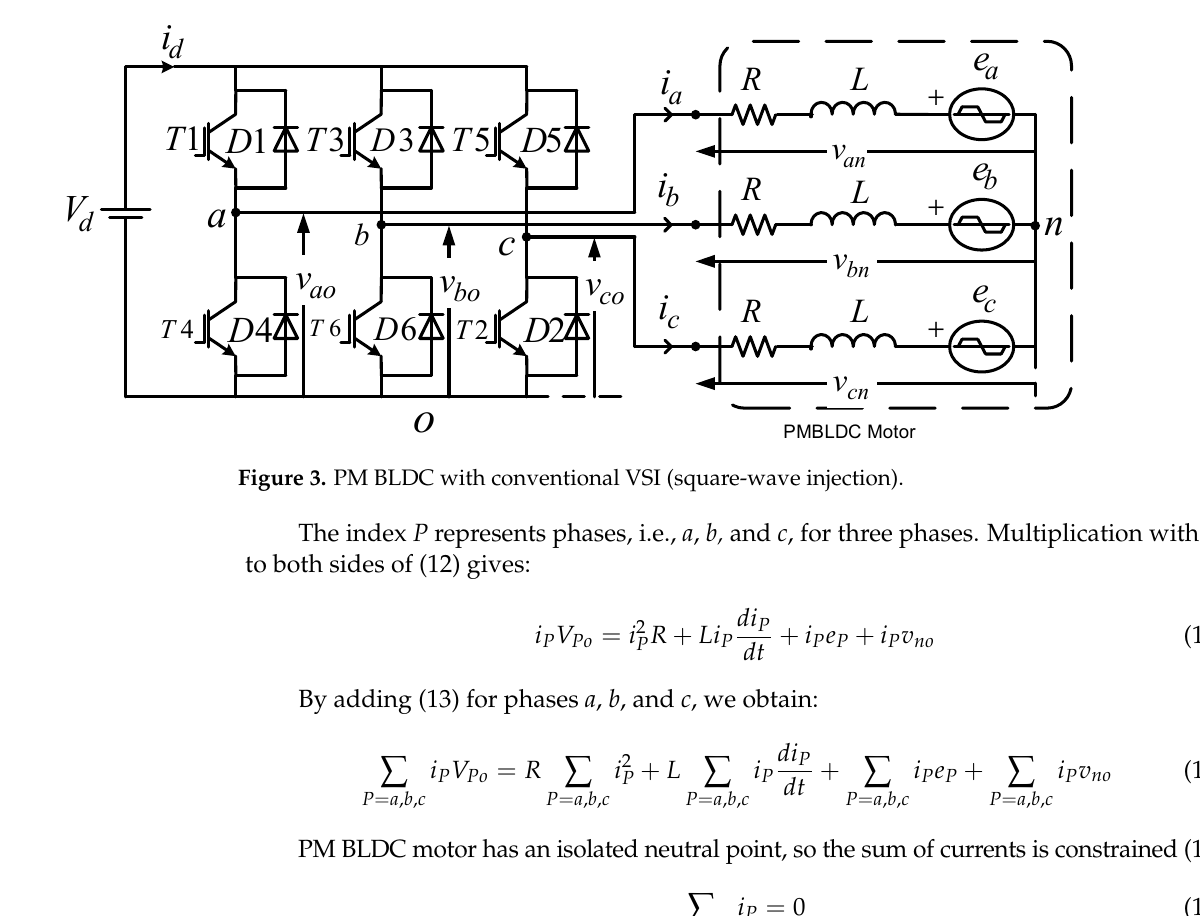
The useful mechanical power obtained from the electrical power is given by (16).